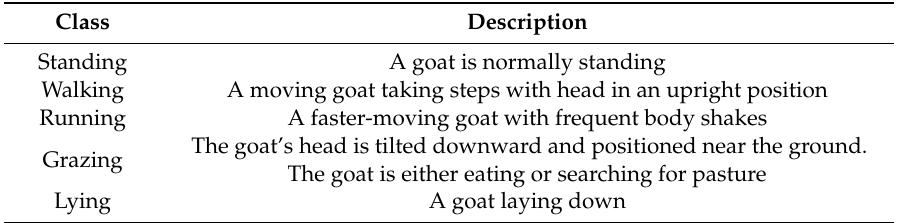
Table 1. Activity classes: the five goat activities described in this study were, standing, walking, running, grazing, and